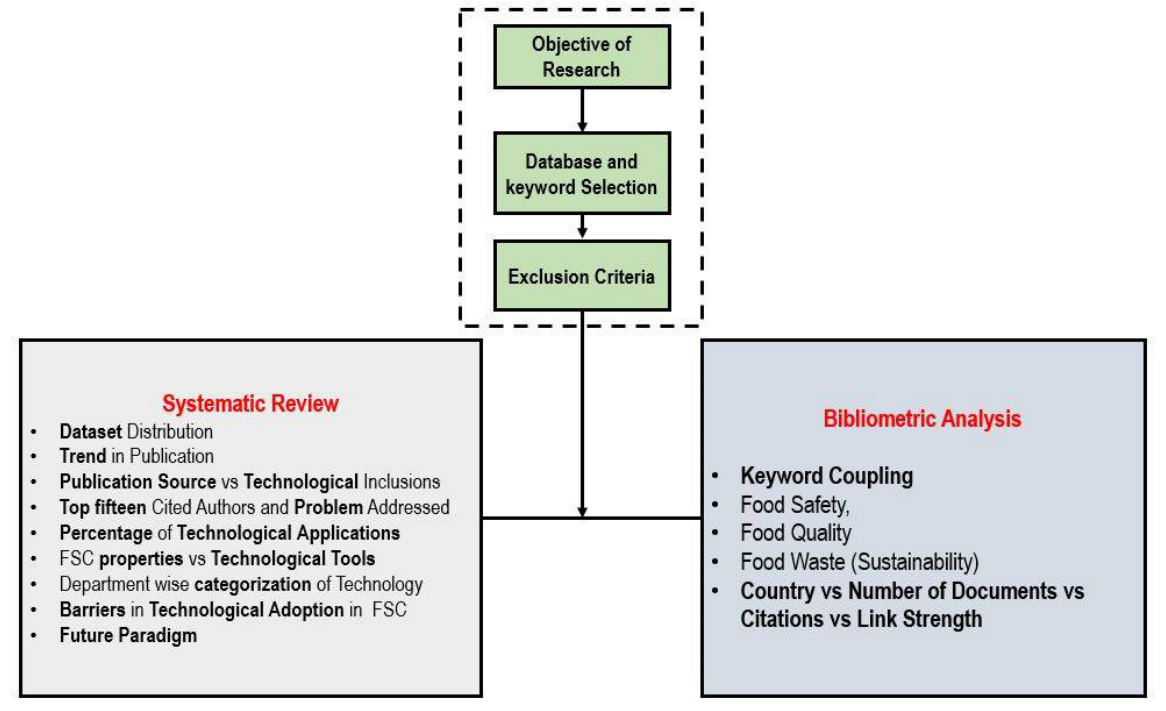
Figure 1. Methodology.